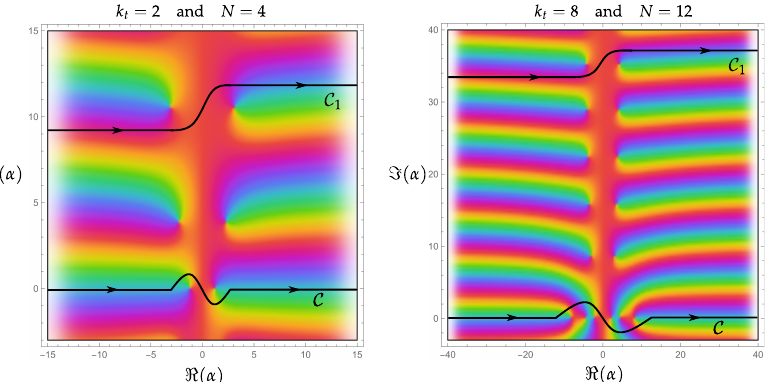
( α ) for ν = 0.3, k t = 2 ( left ) and k t = 8 ( right ). It Figure 6. Phase portrait of the function β t ( α ) / D s shows the location of the poles coinciding with the symmetric modes arising from the dispersion relation (21). The contours and extend horizontally to infinity. It can be shown that the functions C C 1 α decay for large and so the contribution of the contours connecting and at infinity can be | | C C 1 neglected. The contours are chosen to take only the rightward propagating and/or decaying modes. The total number of poles between the two contours is what we call N . On the left plot, N = 4, and 1 of the 4 modes is propagating, while on the right plot N = 12, and 3 of the 12 modes are